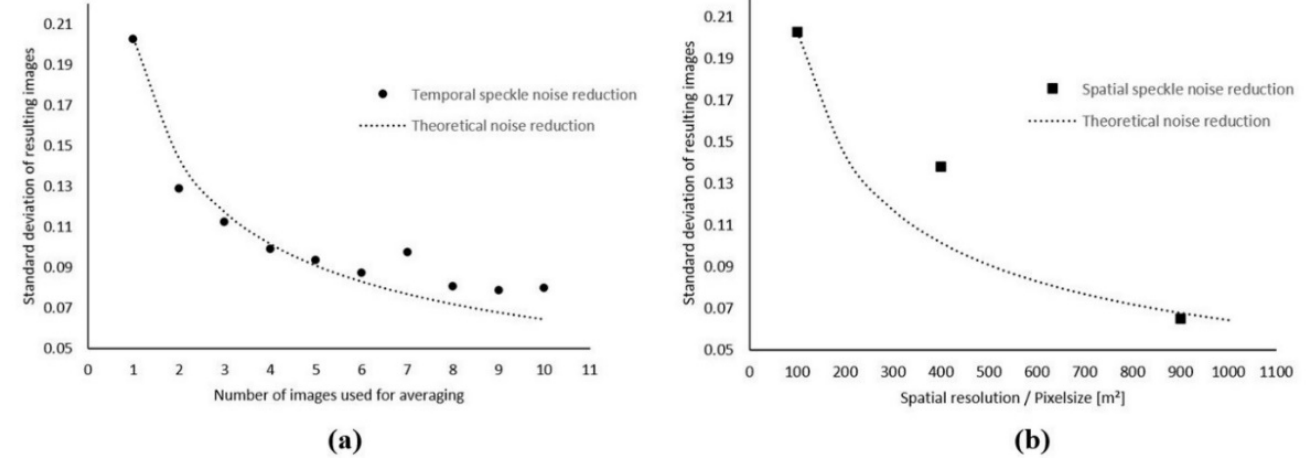
Figure 10. ( a ) Performance of speckle noise reduction by averaging over multiple temporal images compared with the theoretical noise reduction (factor √ n). ( b ) Performance of speckle noise reduction by reducing of spatial resolution compared with the theoretical noise reduction (factor √ n).